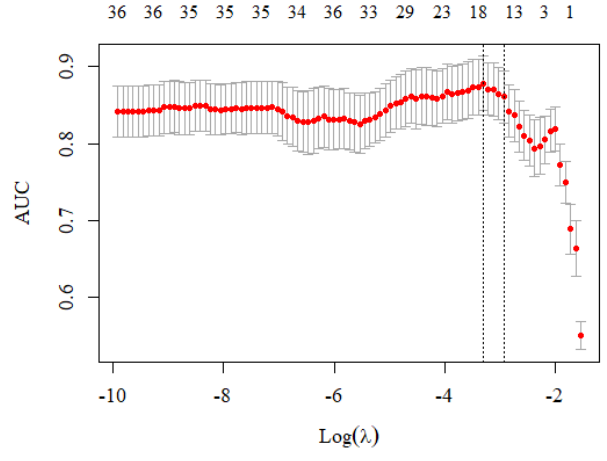
Figure 2. The cross-validation curve at different λ values. The left vertical-dotted line with ln λ = − 3.306 (or λ = 0.037) had the highest AUC value, indicating that the model used 17 variables that had the best prediction performance.